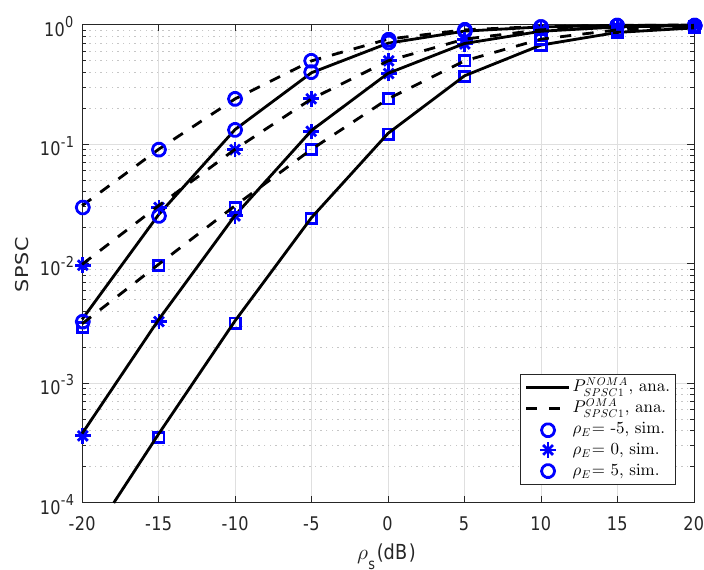
Figure 10. Comparison study of SPSC in several cases versus ρ S = ρ R at D1 as setting different values of ρ E ( λ D 1 = λ E = 1, R 1 = 0.5, R 2 = 1).